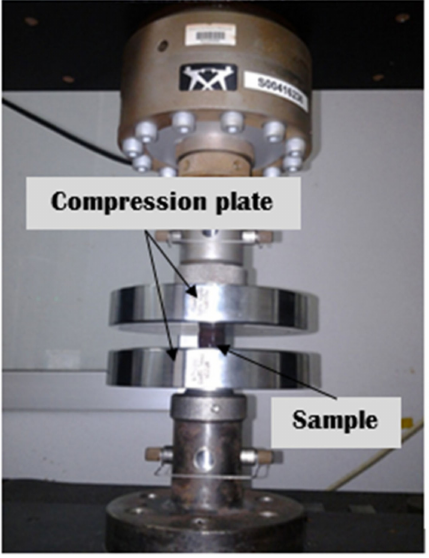
Figure 2. Set-up for compressive strength